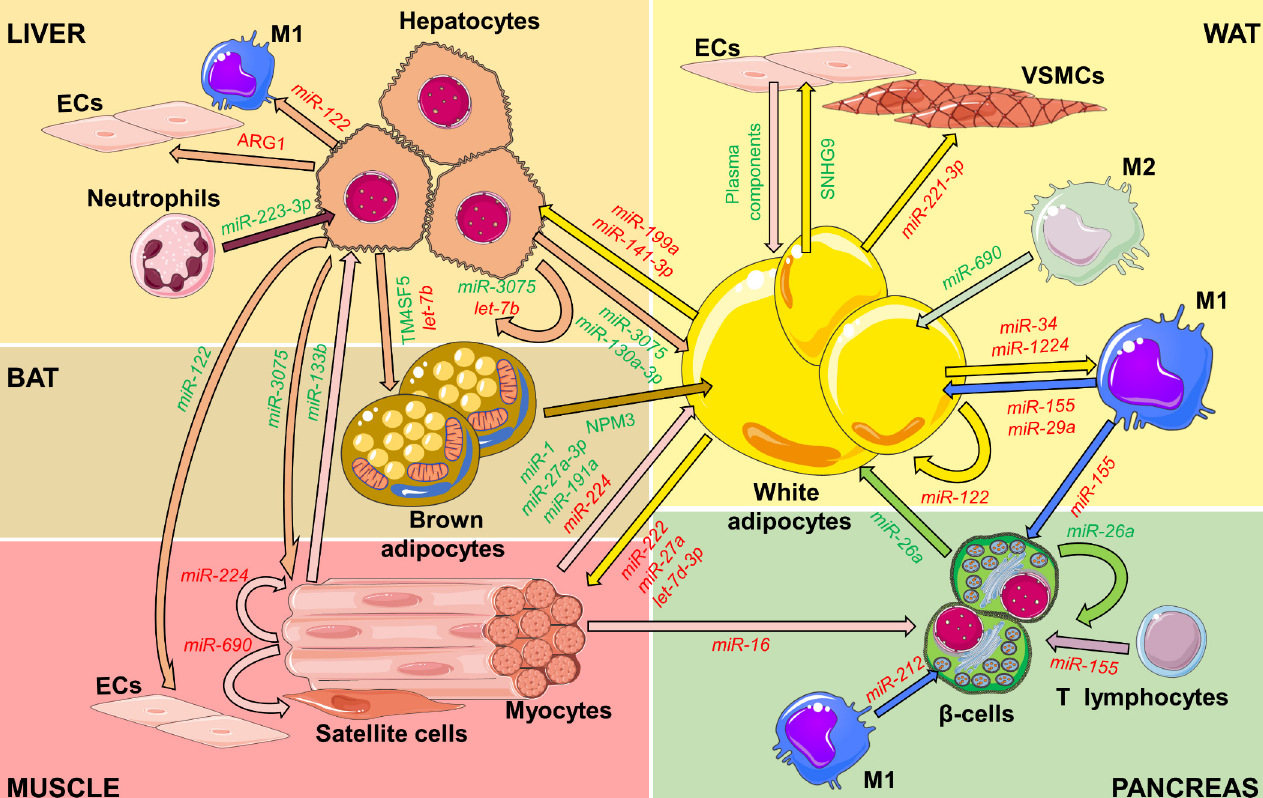
Figure 2. EVs and their cargo participate in inter ‐ organ crosstalk to regulate metabolic homeostasis. EVs released by many cell types can be captured by acceptor cells in an autocrine and paracrine manner, initiating biological responses. In addition, EVs can go into the circulation and reach other organs, driving inter ‐ organ crosstalk. M1: M1 macrophages; M2: M2 macrophages. See text for details.